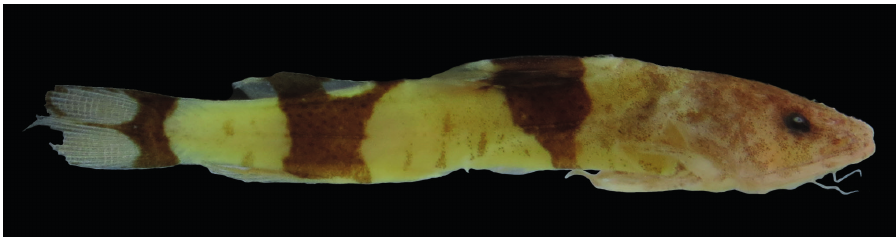
FIGURE 9 | Lateral view of sequenced Rhyacoglanis sp., LBP 1685, 21.6 mm SL, from Barra do Garças, state of Goiás, upper rio Araguaia